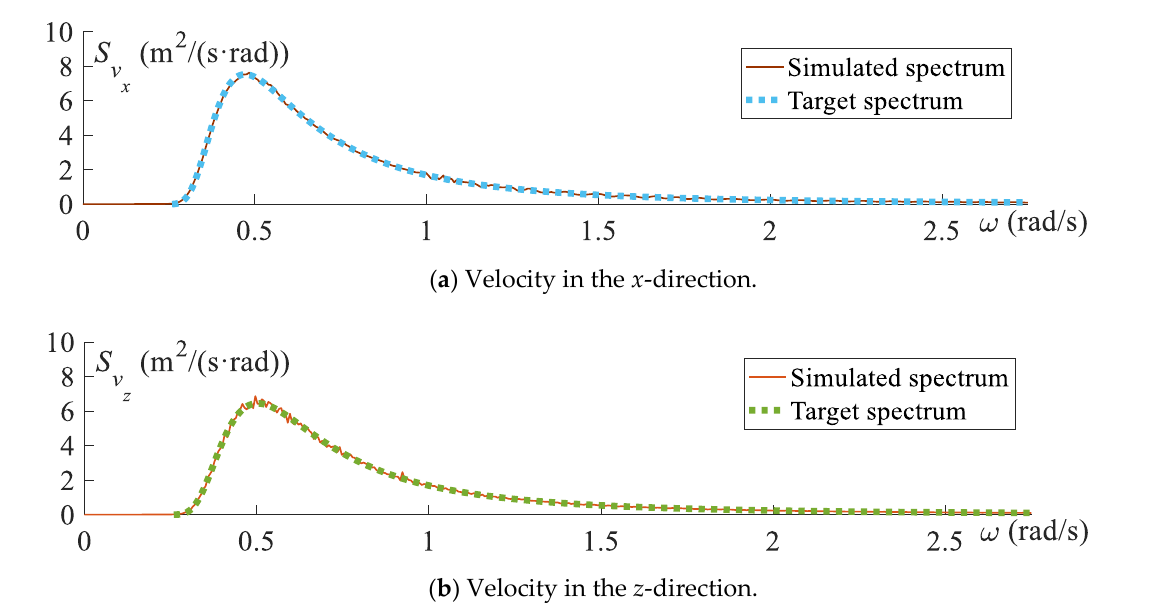
( b ) Velocity in the z -direction. Figure 5. Power spectrum density functions of wave–particle velocities at a still water level ( z = 0).